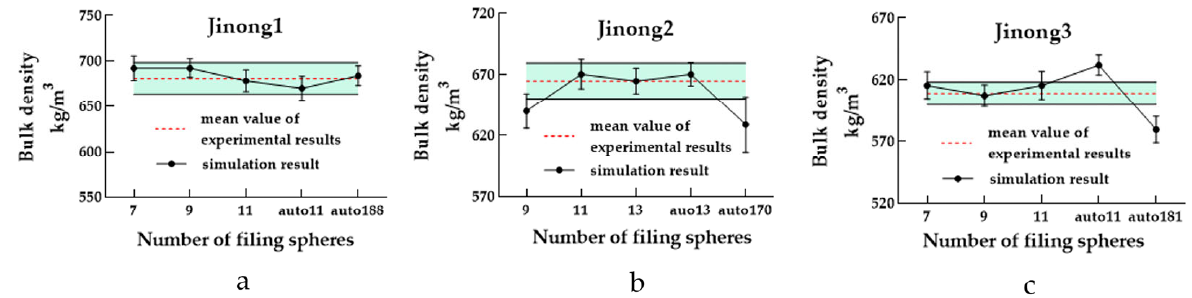
Figure 19. Simulation results of the bulk density test.